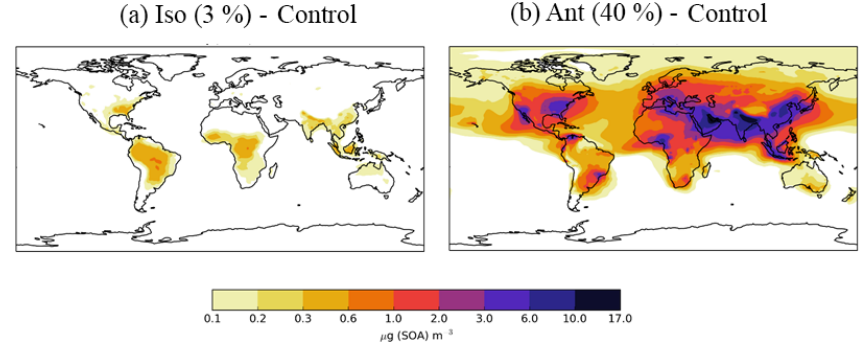
Figure 7. Differences in annual-average SOA concentrations (µgm − 3 ) relative to the control run for further sensitivity simulations, (a) Ant (40%) and (b) Iso (3%). Simulations are described in Table 2.